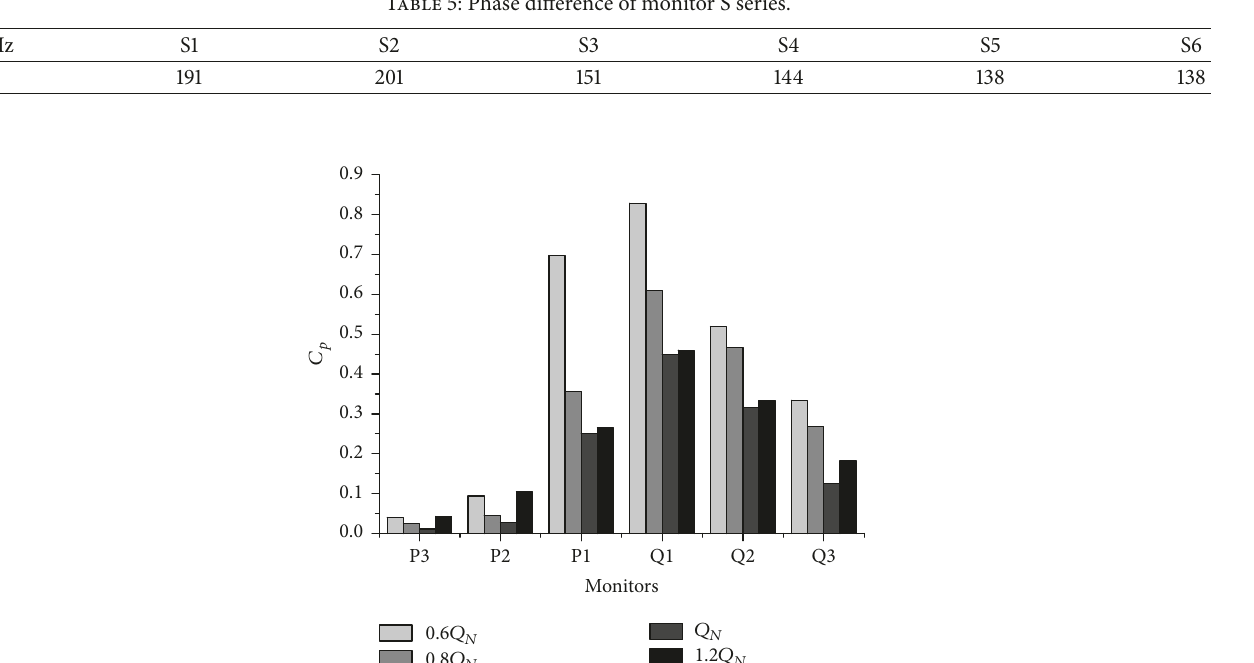
Figure 12: Pressure coefficient amplitude comparison of P3, P2, and P1 and Q3, Q2, and Q1 under multiple conditions.